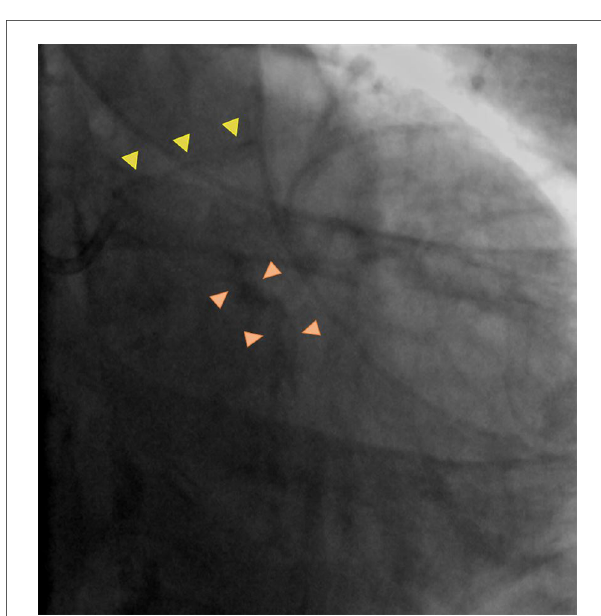
FIGURE 2 Coronary angiography calci fi cation pattern summary. Calcium appears as gray or black outlines, easily assessable when no contrast dye is injected and which follow the coronary artery silhouette, with position excursion in line with vessel movement during the cardiac cycle. Mild calci fi cation is de fi ned as appearance of the calci fi ed component only on one side of the vessel (yellow arrowheads), whilst severe calci fi cation is de fi ned as appearance of the calci fi ed component on both sides of the